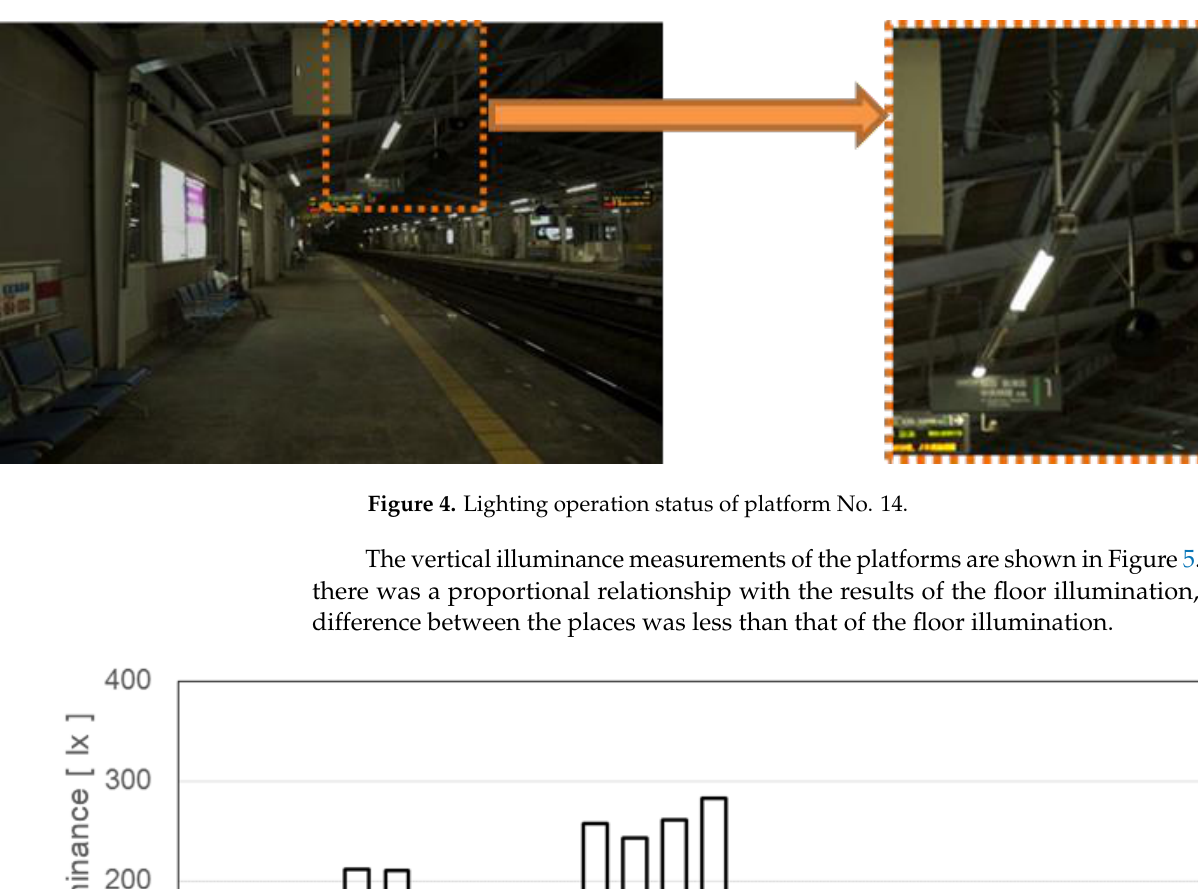
Figure 3. Measurement results of the floor illuminance of the platforms.